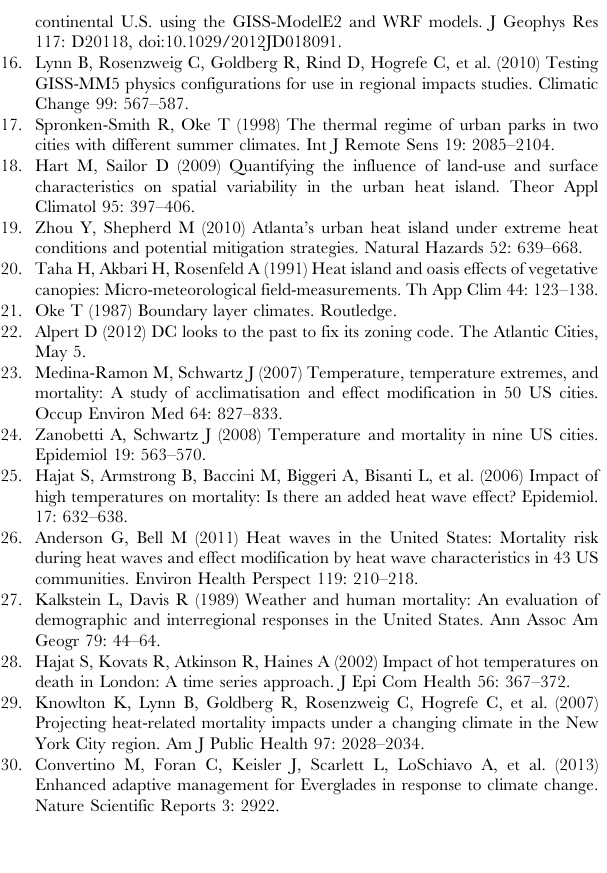
AvgapT, and MinT) for five-member ensemble runs in which initial conditions were modified for the BAU scenario. Table S1 Mean warm season (May-Sept) standard errors ( 6 C) from ensemble simulations by temperature metric and